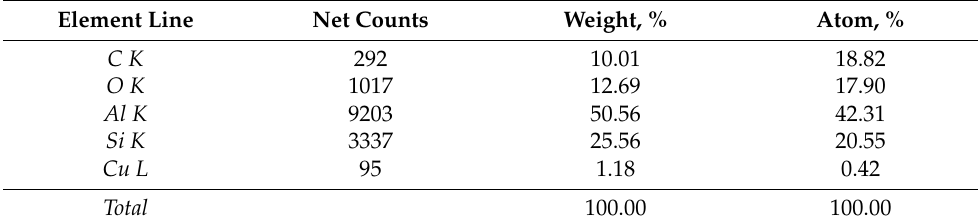
Table 3. Results of EDS analysis on the studied